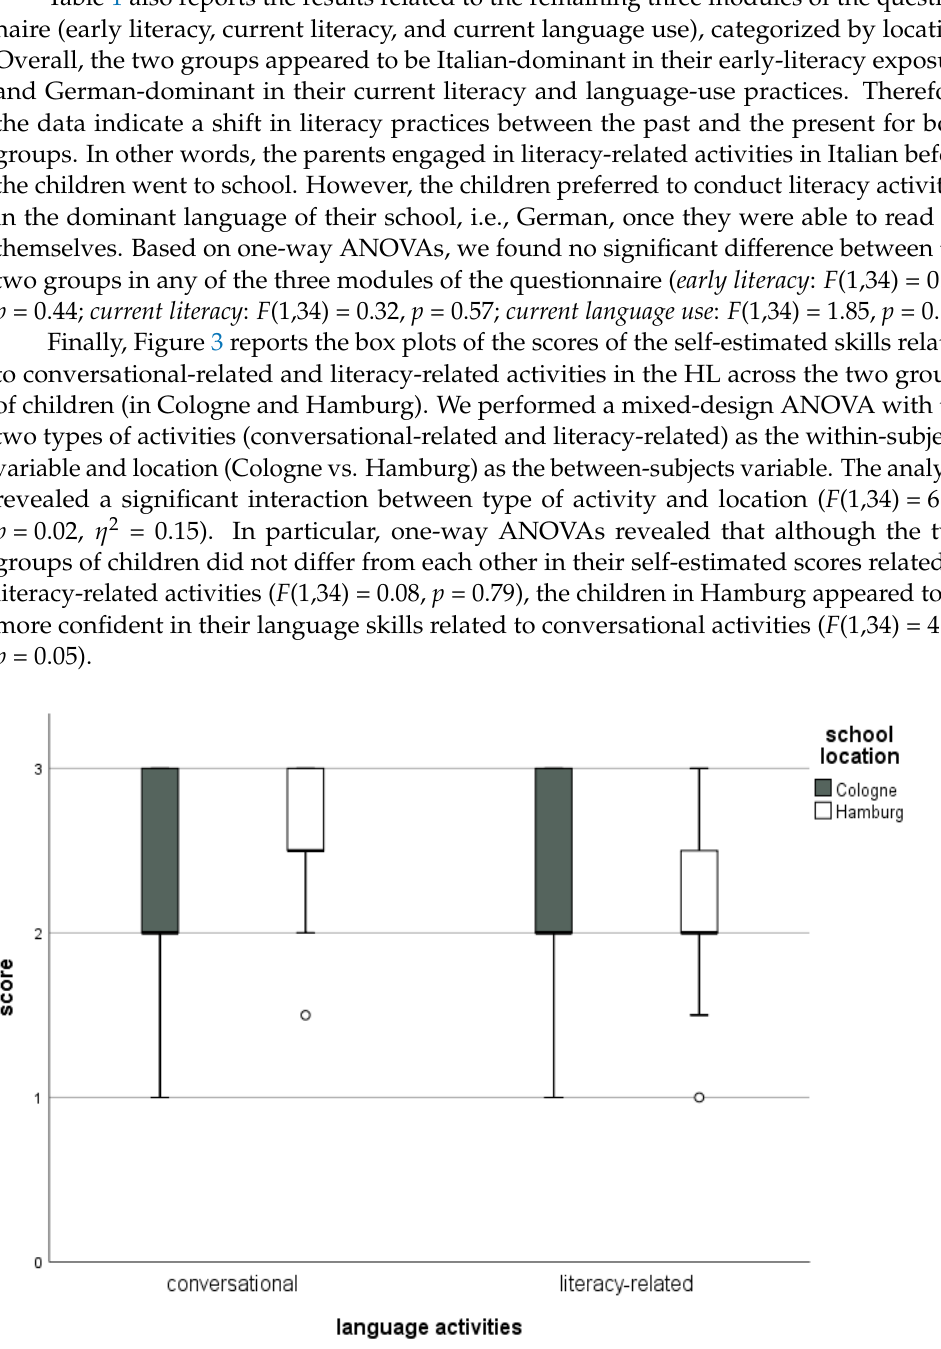
Figure 3. Box plot of the scores of the self-estimated language abilities related to conversational-related (understanding/speaking) and literacy-related (reading/writing) activities across the two groups of children (living in Cologne and Hamburg).